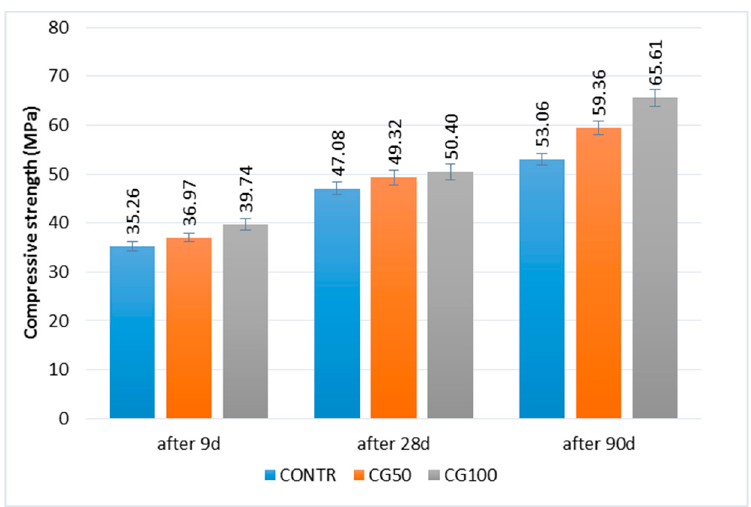
Figure 5. Compressive strength of concrete with RGA; in the form of error bars, the standard deviation is shown.